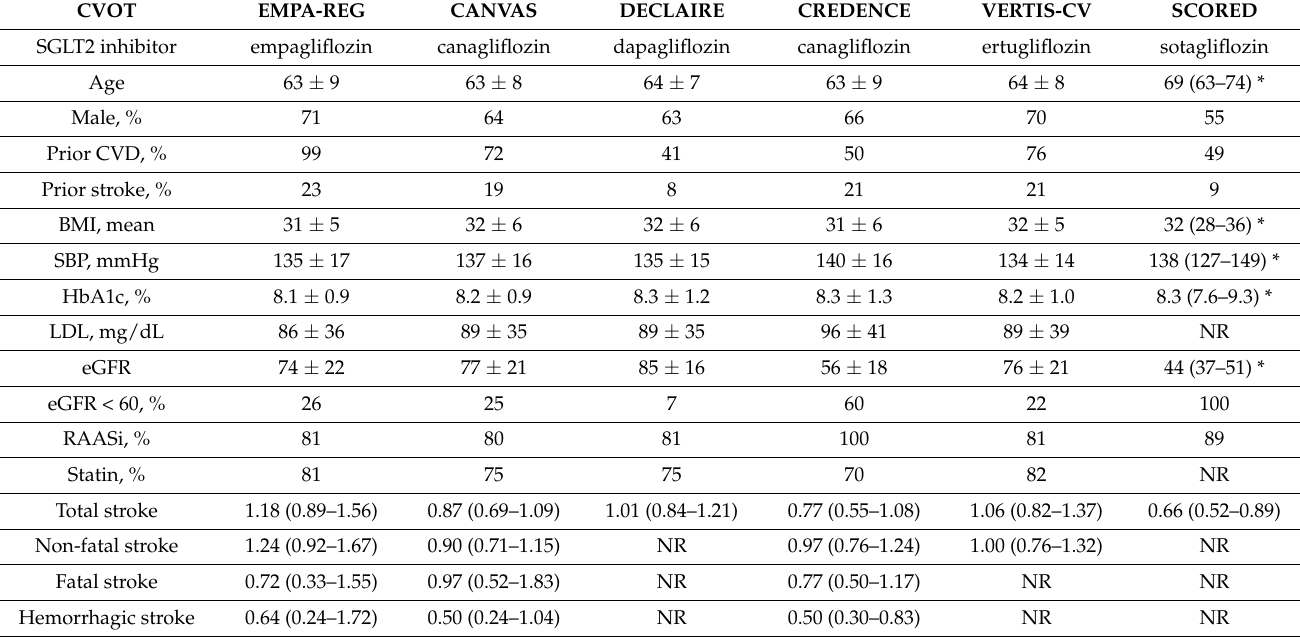
Table 1. Baseline demographics and stroke outcomes in cardiovascular outcome trials of each sodium–glucose cotransporter-2 (SGLT2)